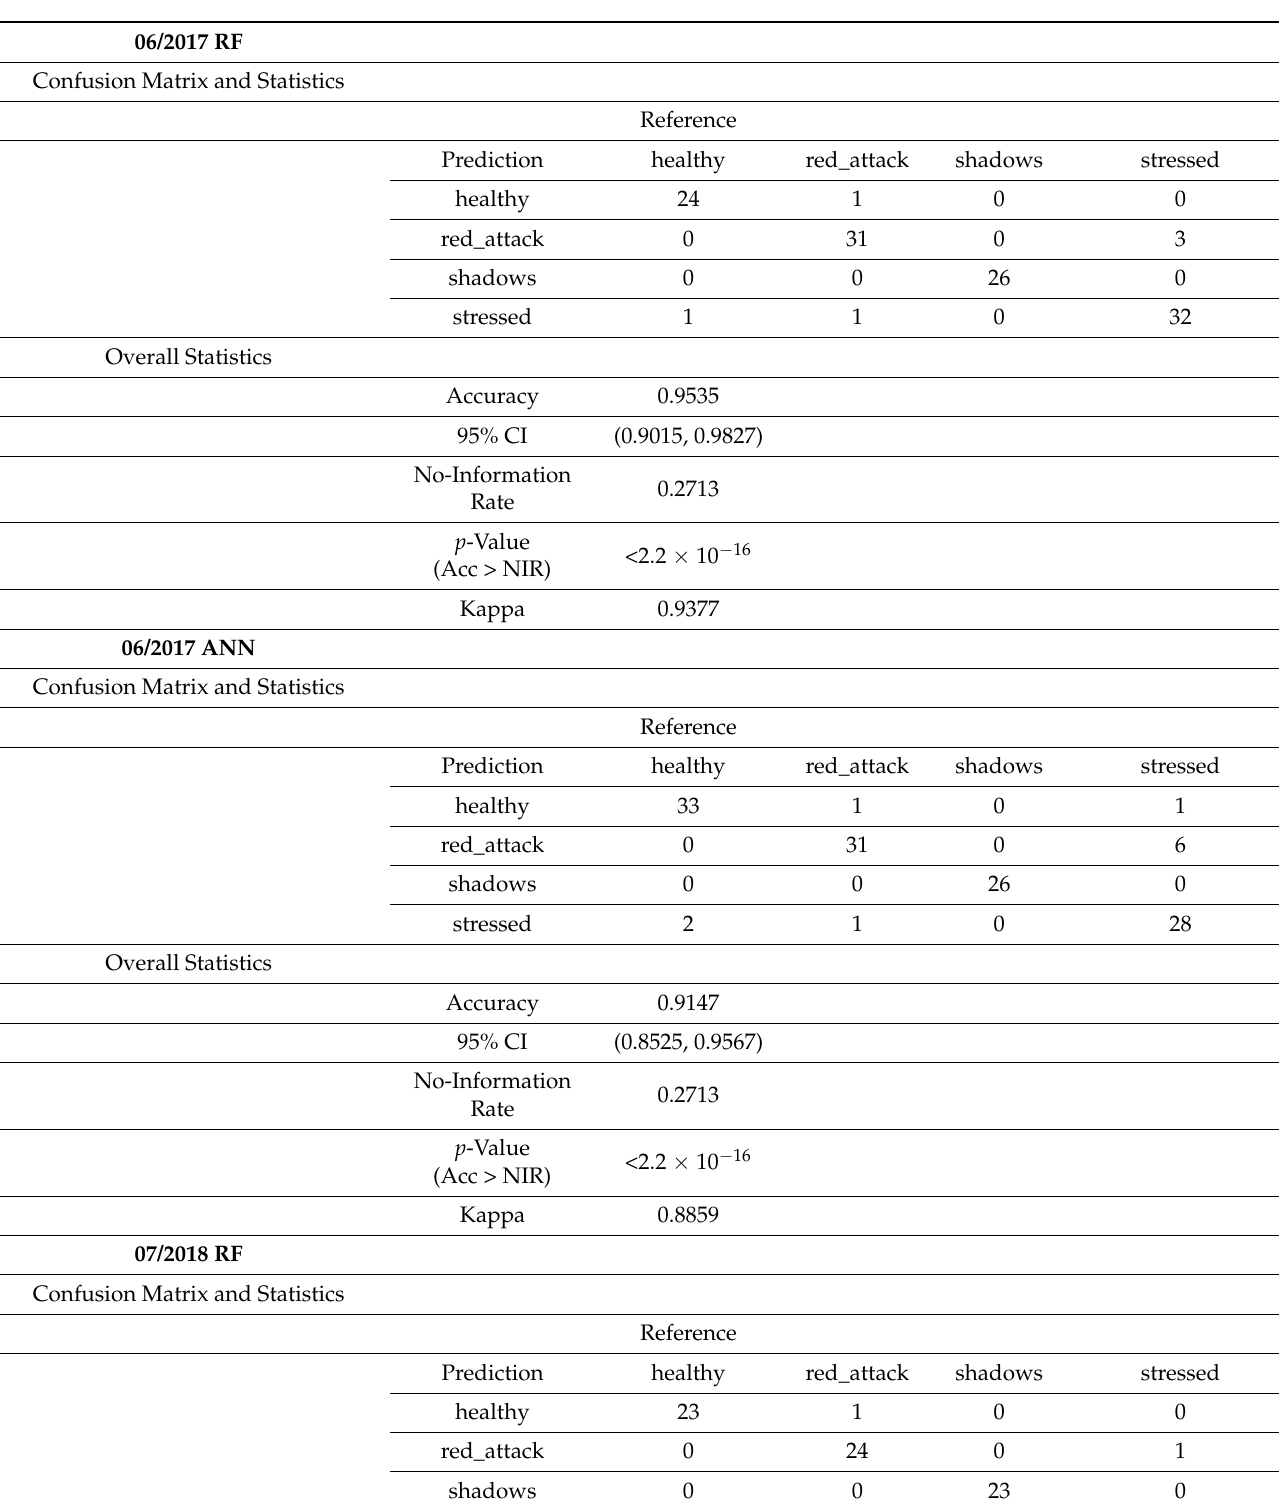
Table A1. Confusion matrices and overall statistics for RF and ANN for each classification